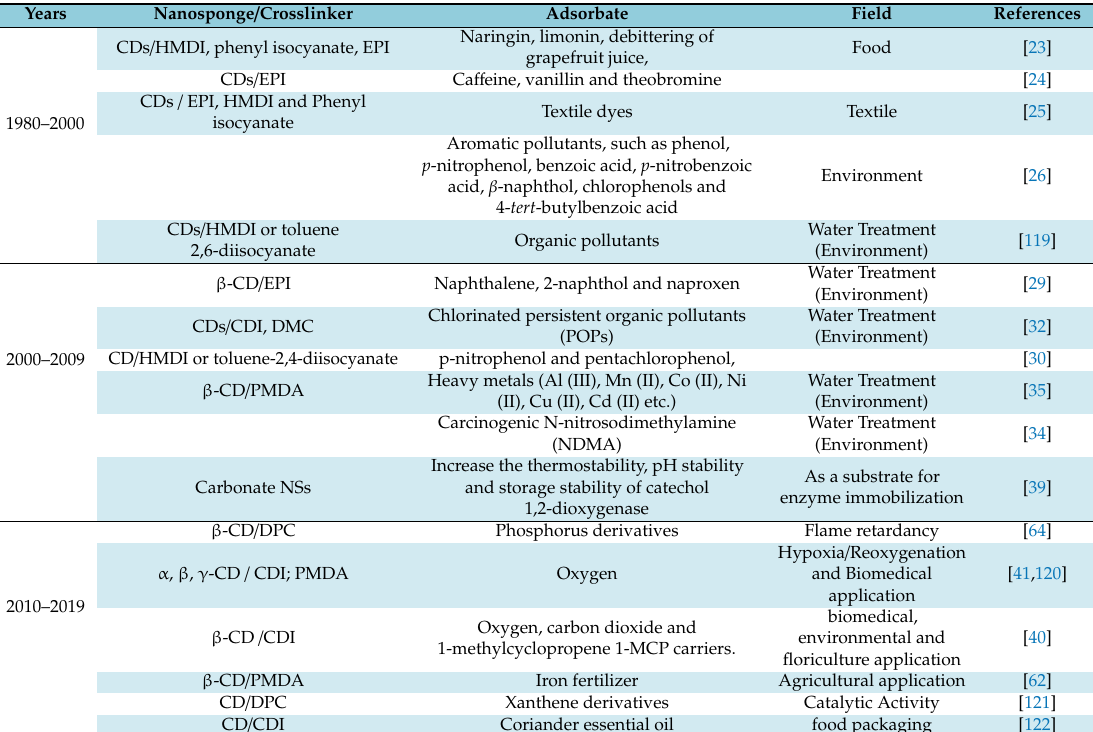
Table 2. Historical excursus of publications on CD-based NSs employed in food, textile, environmental fields,